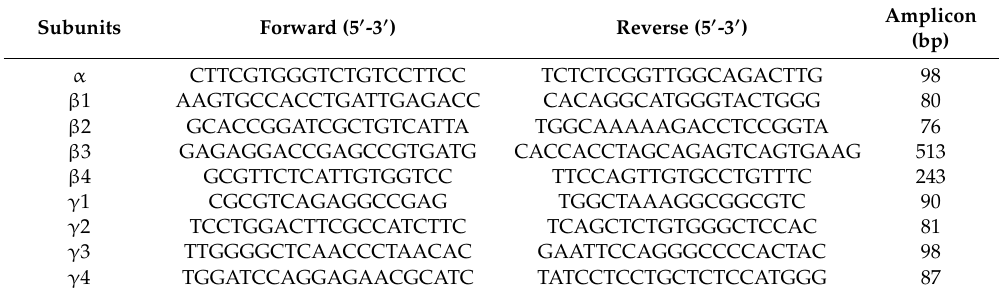
Table 1. Primers used for detecting human large conductance Ca 2 + -activated voltage-dependent potassium (BK Ca ) channel subunits by